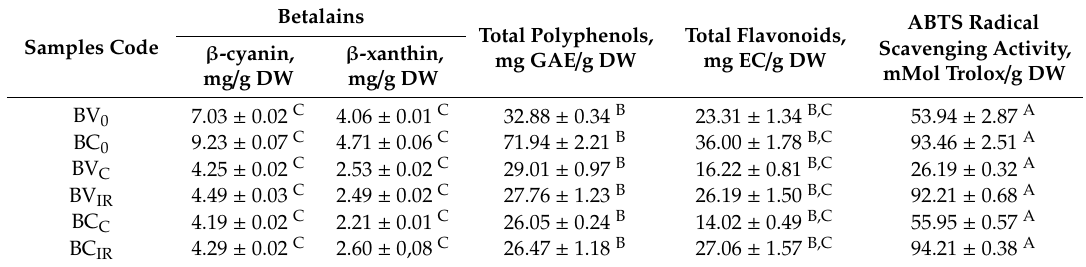
Table 1. Phytochemical profile of fresh and dried red beetroot pur é